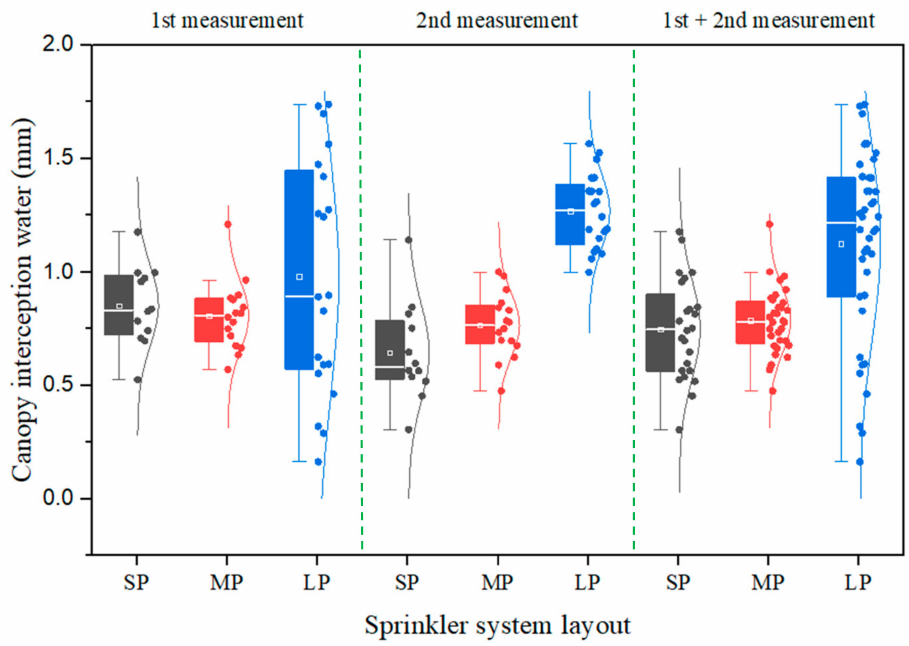
Figure 3. Distribution of canopy interception water under the three sprinkler system layouts in the two